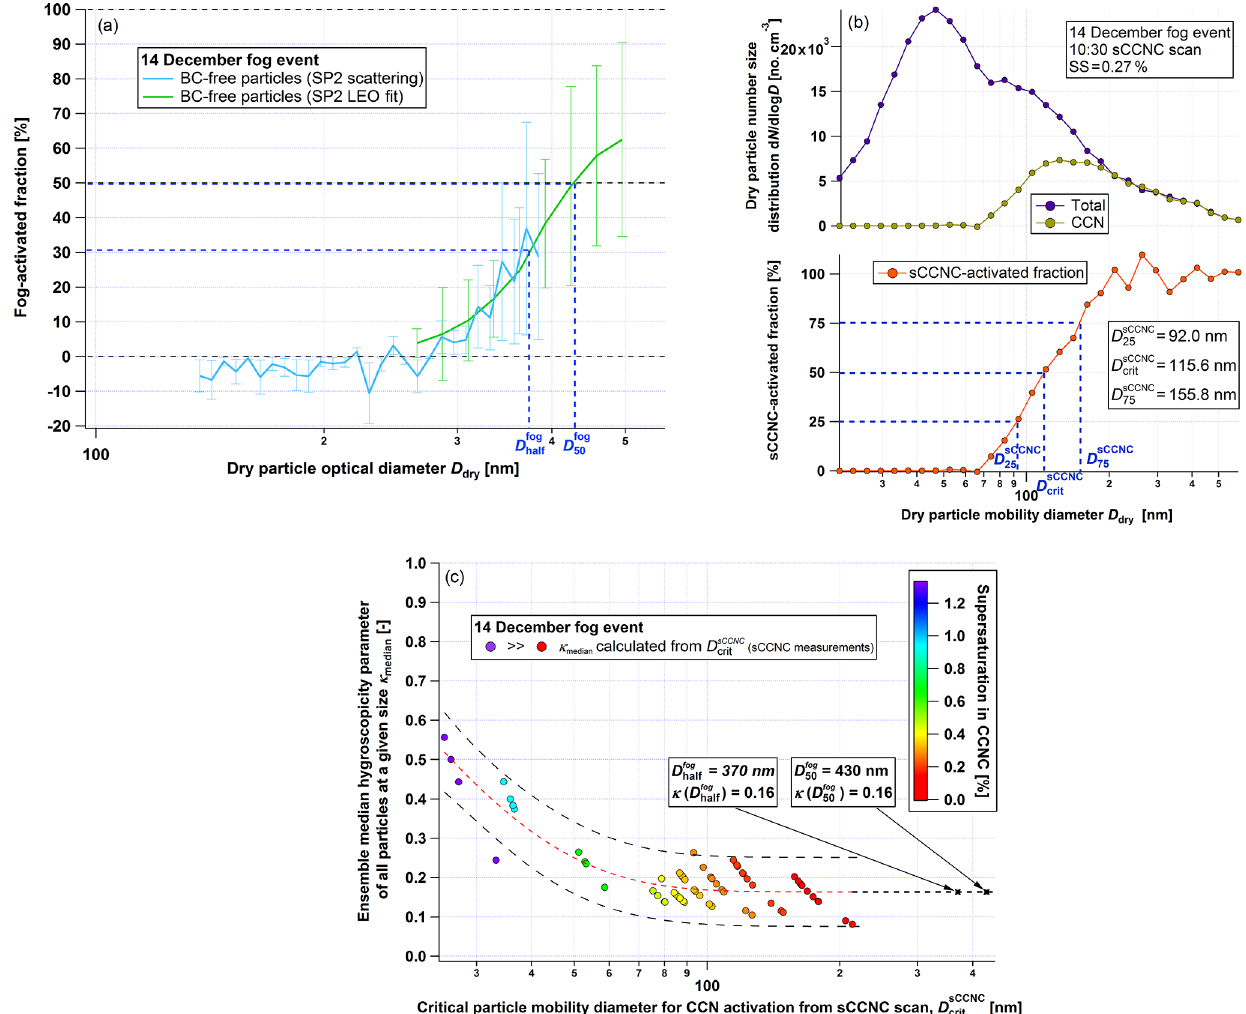
Figure 3. Example data from the 14 December fog event. (a) sCCNC-activated fraction spectrum including D fog and D fog from SP2 50 half measurements. D fog and D fog along with κ median values from sCCNC measurements are used to obtain two estimates of fog SS peak . (b) Total 50 half particle and CCN number size distribution from sCCNC measurement and corresponding sCCNC-activated fraction spectrum at a fixed SS used to infer D sCCNC and the corresponding κ median value. The normalized difference between the 75% and 25% activation cut-off crit − D sCCNC )/D sCCNC diameters, ( D sCCNC , is used as an indicator of aerosol mixing state. (c) κ median values calculated from individual 75 25 crit D sCCNC retrieved from the sCCNC scans plotted against D sCCNC on the abscissa. The points are coloured by the SS applied in the sCCNC. crit crit The red line indicates an exponential fit surrounded by 95% confidence intervals which reflect temporal variability during the fog event. The two black crosses affixed on the dashed line indicate an extrapolation of κ median to D sCCNC corresponding to D fog and D fog . Note: the crit half 50 peculiar size dependence of the κ value, which exhibits increasing hygroscopicity with decreasing particle size, has been observed during the fog events and also a few other fog-free nights covered in this study (see Fig. 4). However, this feature at the small size end is not relevant for fog droplet activation nor is it representative of the campaign averaged data (see Table